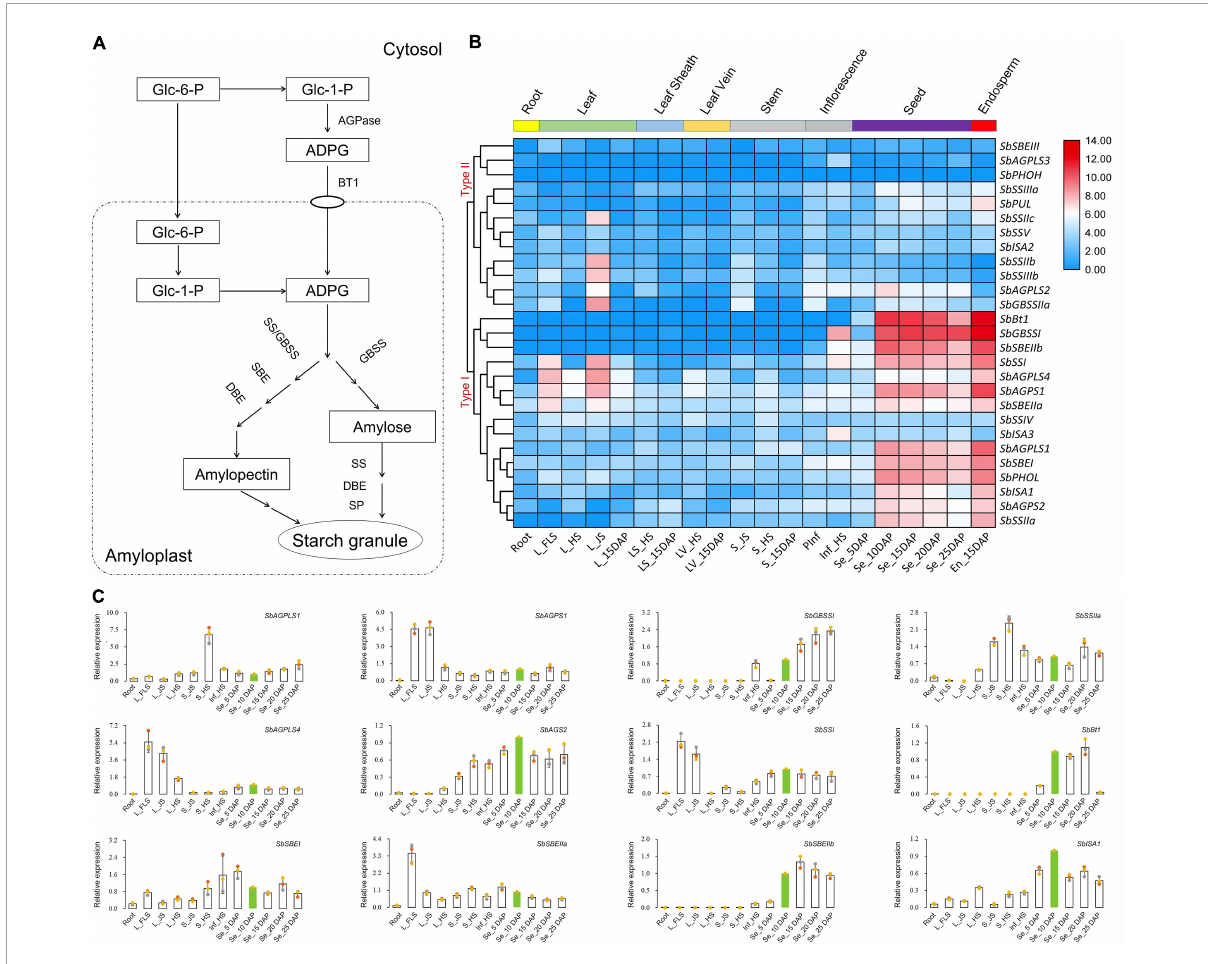
FIGURE3 Heat map-based clustering analysis and expression dynamics dissection of 27 identified starch biosynthesis-related genes in sorghum. (A) Starch biosynthesis pathway in cereal endosperm (Jeon et al., 2010). (B) Heat map generated by hierarchical clustering via Pearson’s correlation as a measure of similarity. Red, white, and blue indicate high, medium, and low levels of gene expression, respectively. (C) qRT-PCR-based expression dynamics dissection of 12 selected genes highly expressed in grains via RNA-seq. Green-filled bars referred to the tissue/sample of Seed_10DAP with relative expression levels standardized to